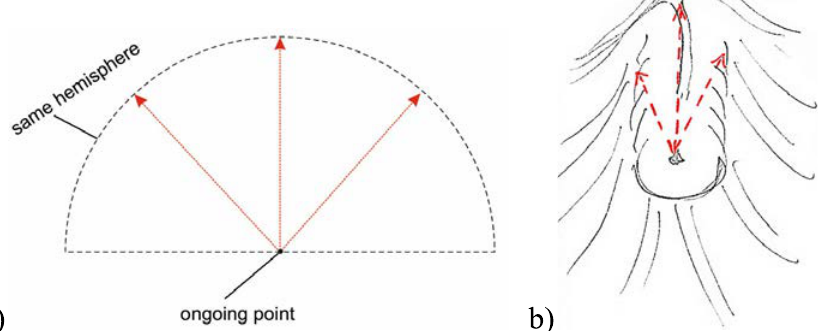
Figure 5 Incision direction in a